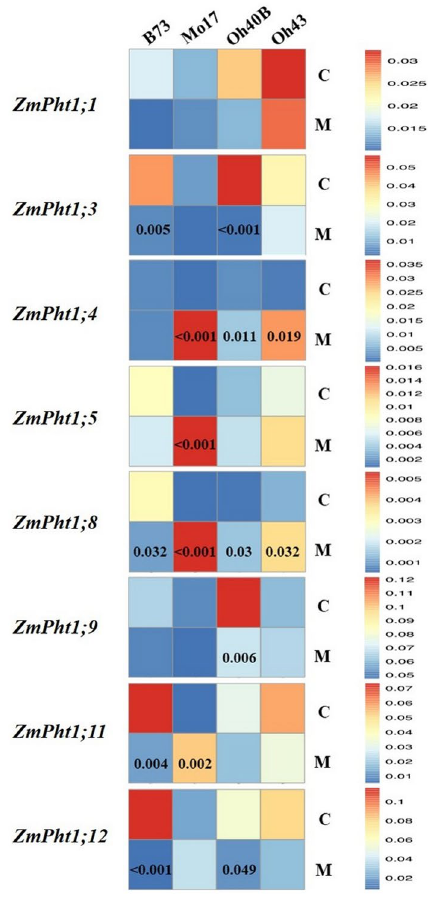
Figure 1. Heat map based on normalized expression of P transporter ( ZmPht1 ) transcripts in roots of Zea mays plants belonging to four inbred lines, in symbiosis (M) or not (C) with Rhizoglomus irregulare , under low phosphorus availability (0.47 mg kg −1 ). Mean gene expression was scaled independently for each phosphate transporter from blue (minimum) to red (maximum). Significant differences between treatments for each phosphate transporter are indicated by the relevant P values (Tukey’s HSD post hoc test). Expression levels were normalized against the ZmActin1